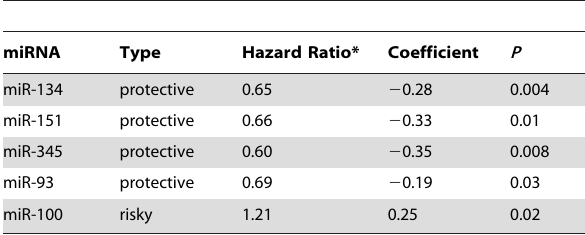
Table 3. Cox regression analysis of five miRNAs for all the lung cancer patients with malignant effusions.